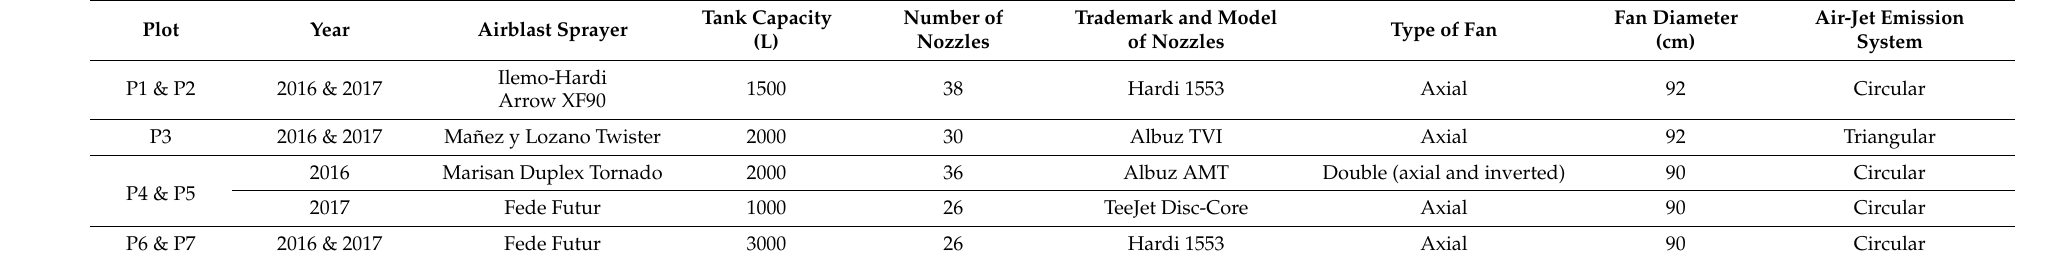
Table 2. Airblast sprayers used in the applications.